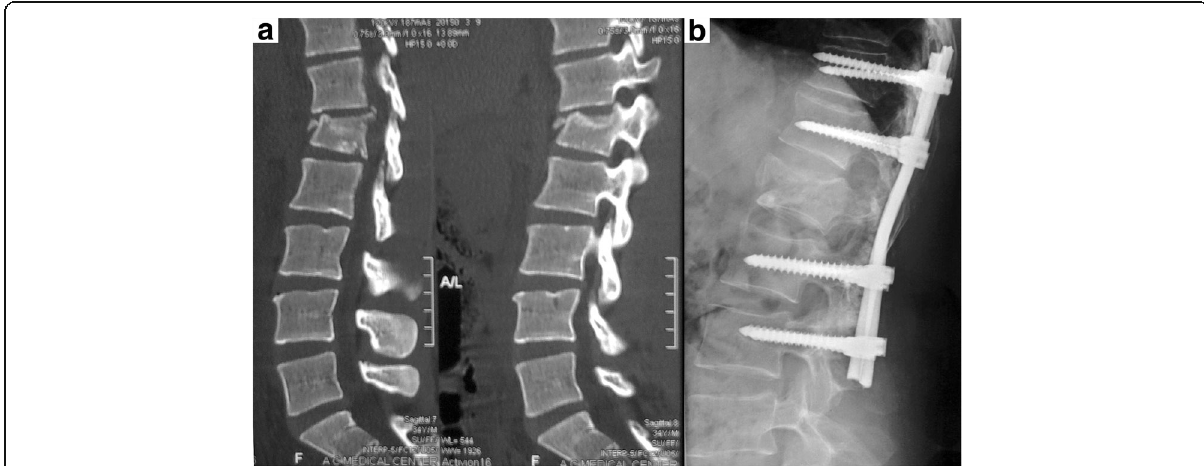
Fig. 2 a Pre-operative CT of L1 fracture. b Post-operative X-ray lateral view of the long-segment